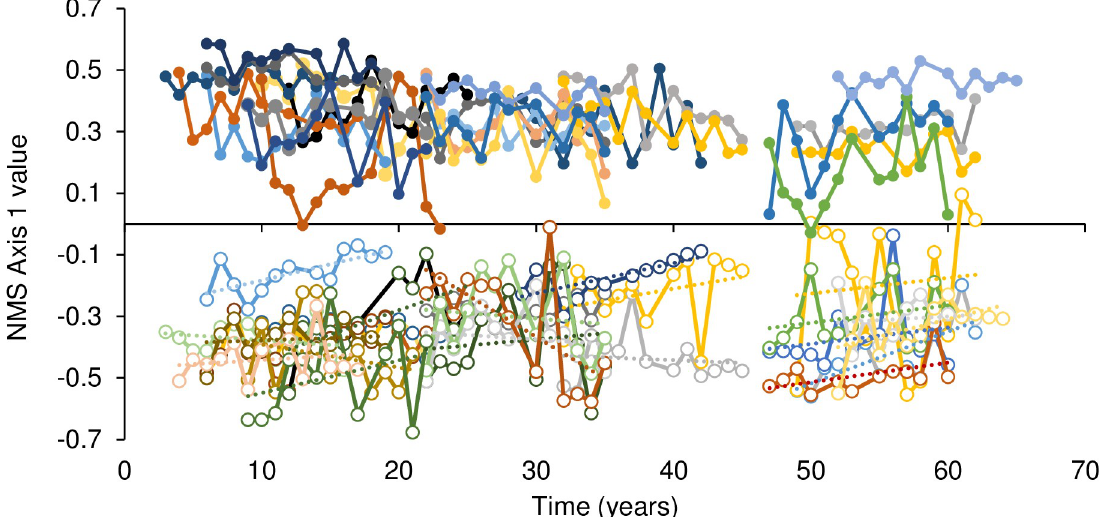
Fig 3. NMS axis 1 scores (species matrix) over time. Data from ex-arable fields shown with open symbols and data from never-tilled fields shown with filled symbols. Data from transects located 50 m from tillage boundaries. Positive y-axis values were associated with native, long-lived perennial communities (Table 1; Fig 1). NMS 1 values increased with time during 13 years of observation in ex-arable fields, but did not change with time in never-tilled communities or across the chronosequence in either community type.